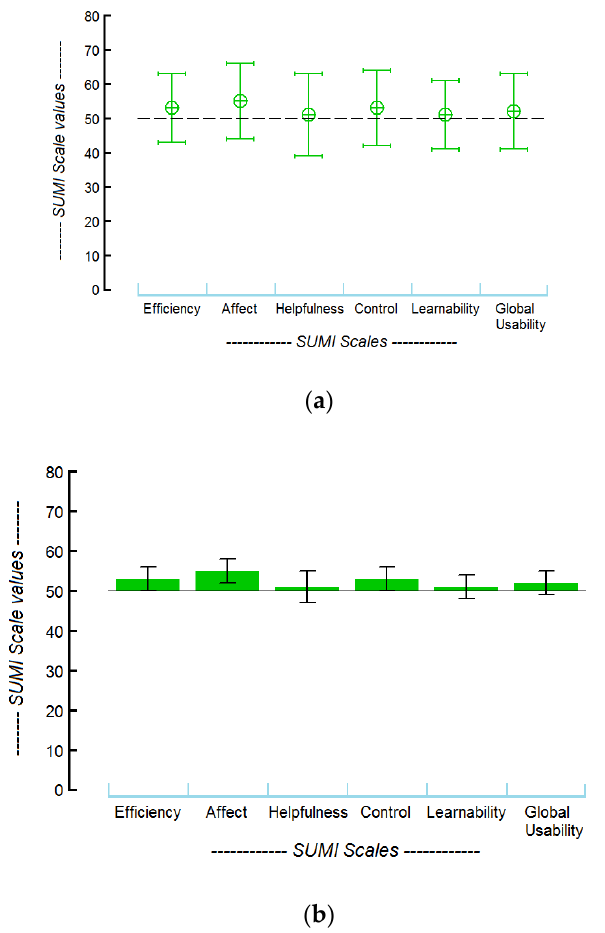
Figure 2. ( a ) Means and Standard Deviation. ( b ) Means with 95% CIs. Table 3. Items indicating statistically significant